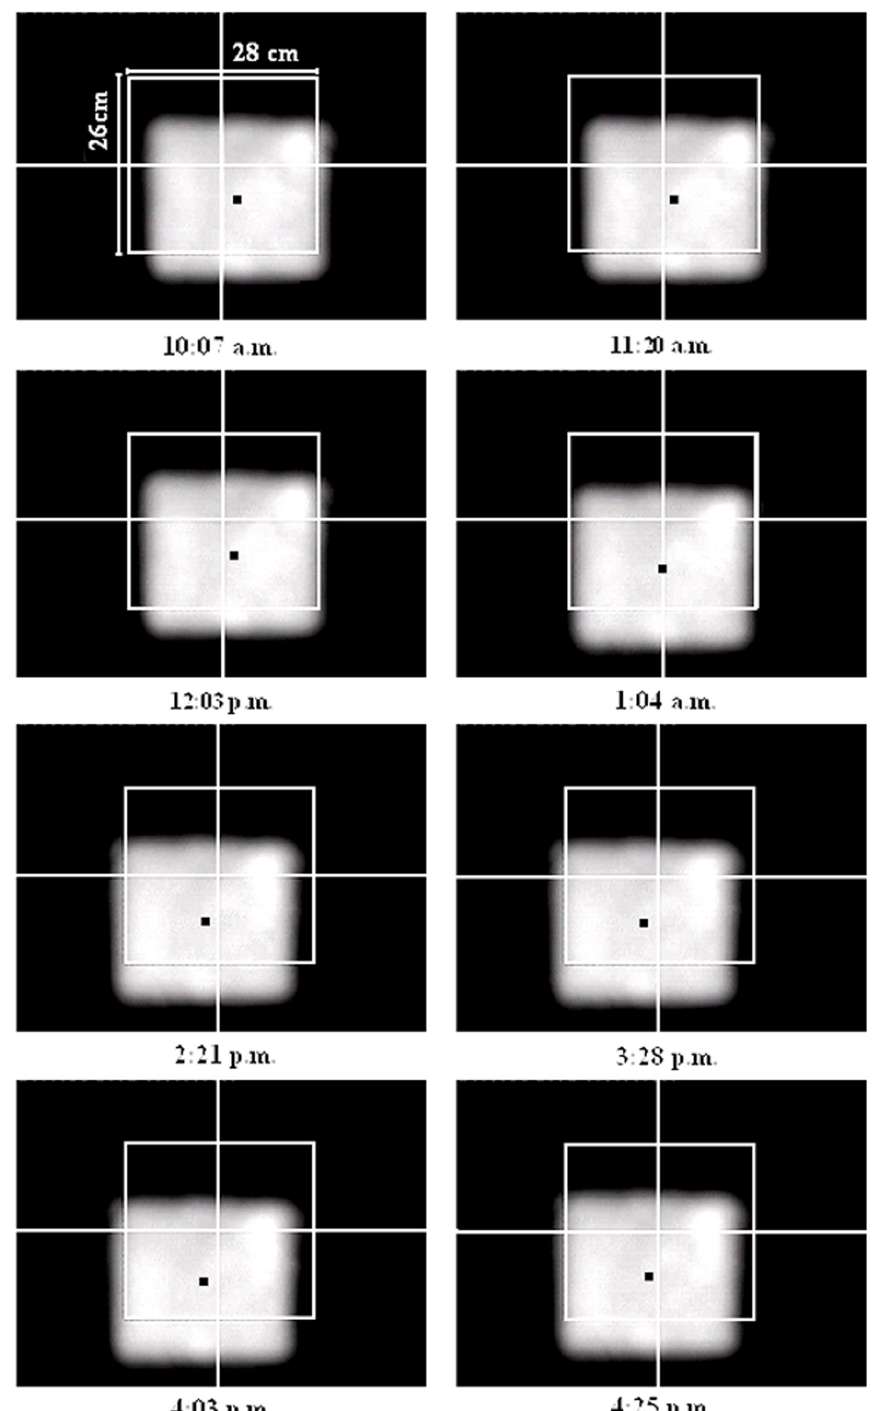
Figure 5. The recorded solar images on the target of prototype solar concentrator using a CCD camera from 10:07 am. to 4:25 pm. on 13 January 2009 with φ = λ = ζ =